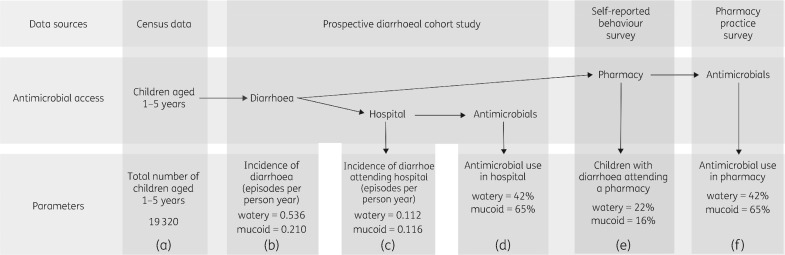
Estimating antimicrobial usage for diarrhoea in children aged 1–5 years in pharmacies and hospital. Diagram outlining the sources of data, parameters, and calculations used to quantify antimicrobial usage for diarrhoea in children aged 1–5 years in this population. Note each of the parameters have been given an initial (A–F), which informs the calculations in Table 3.